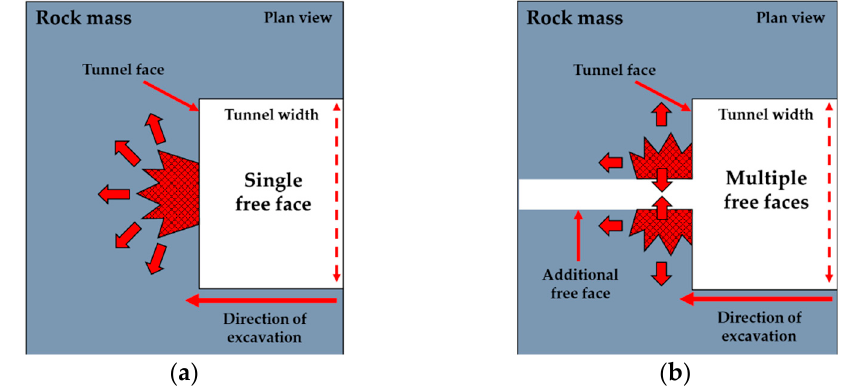
Figure 1. Comparison of ( a ) general tunnel blasting and ( b ) controlled tunnel blasting using the LLB method [8].